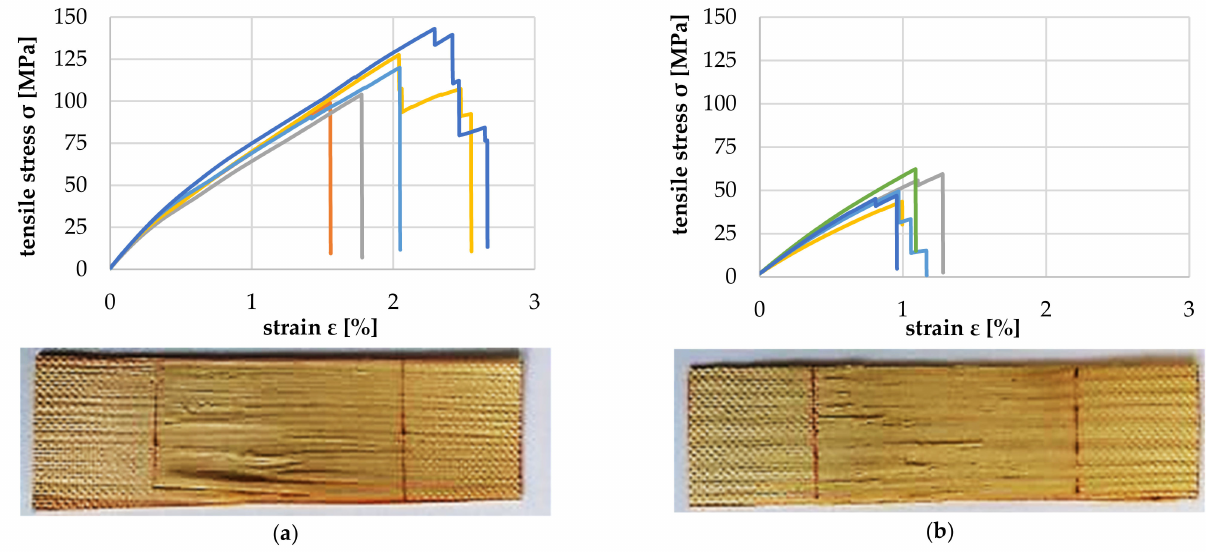
Figure 17. Tensile properties for a growth ring width of 1 mm ( a ) and 2 mm ( b